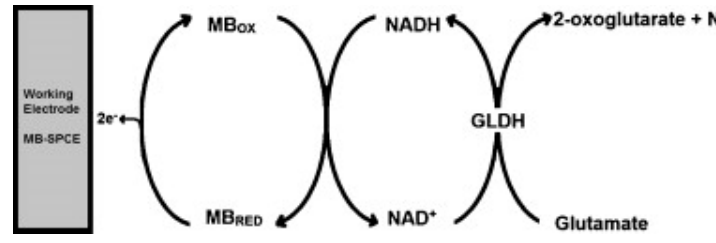
Figure 2. A schematic diagram displaying the layer-by-layer drop coating fabrication procedure used Figure 2. Schematic displaying the interaction between the immobilized enzyme GLDH and glutamate to construct the reagentless glutamate biosensor, based on a MB-SPCE electrode. Reproduced with at the surface of the electrode and the subsequent generation of the analytical response. Reproduced permission from [22]. with permission from